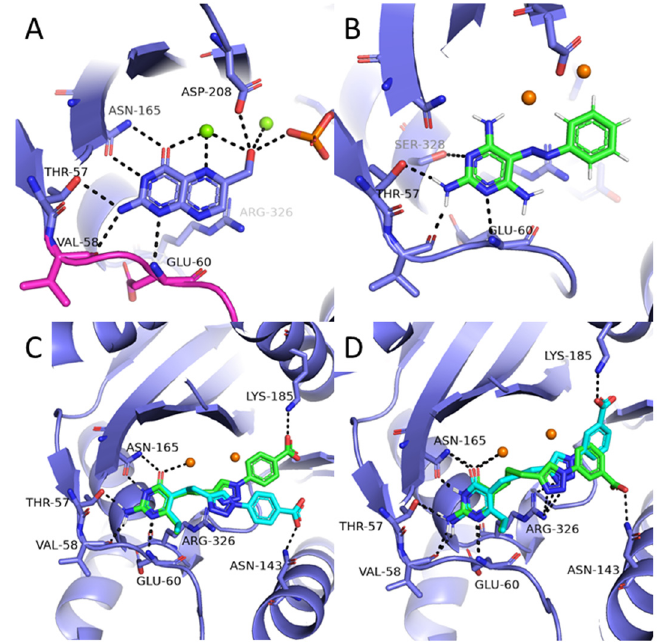
Figure 5. Binding mode of antifolates in HPPK active site. ( A ) Co-crystal structure of HMDP substrate in Pf HPPK (PDB 6JWR) [12]. Residues showing important conformational changes between apo and HMDP-bound form appear in pink. ( B – D ). Binding mode of compounds 4 , 11 and 14 , respectively, obtained by molecular docking. Two possible binding modes were proposed for compounds 11 and 14 and appear in green and cyan. Mg 2+ ions were shown as spheres.